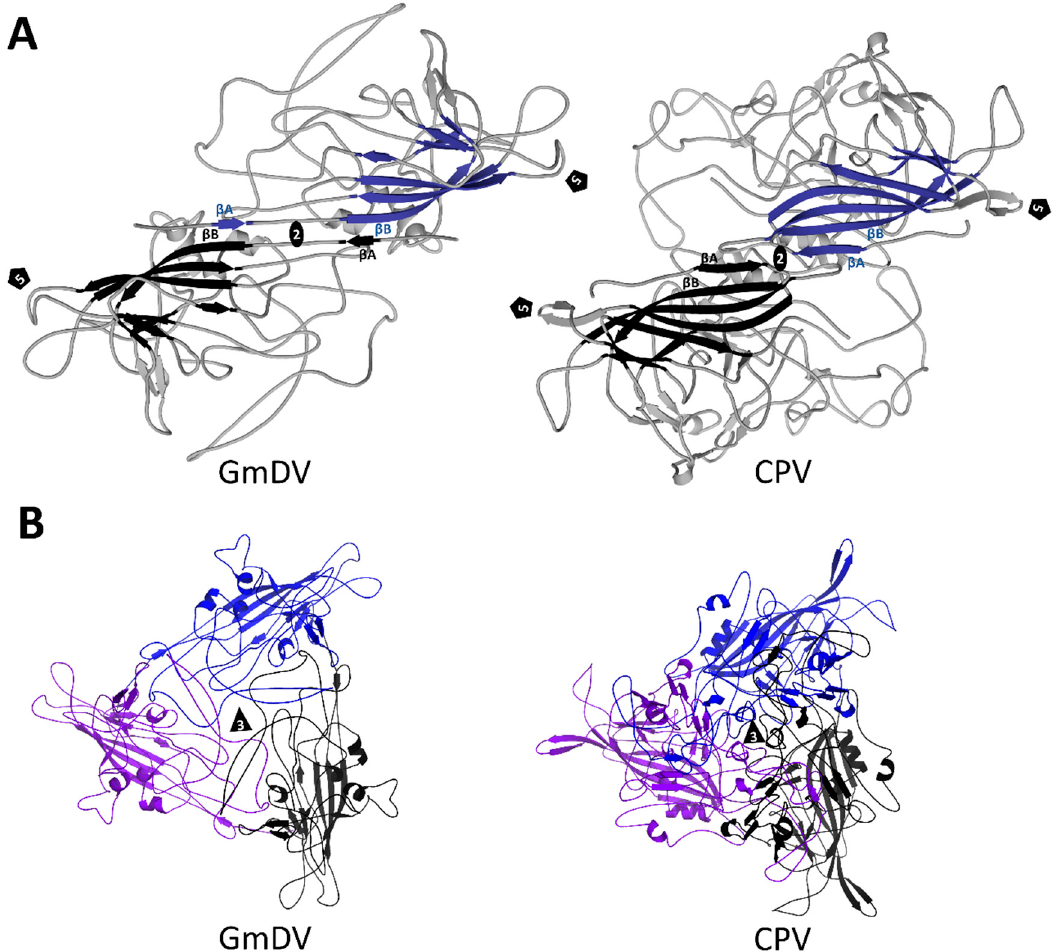
Figure 13. Multimeric interactions of densoviral and parvoviral VPs. ( A ) Ribbon cartoon diagrams of the interactions between β A and β B at the 2-fold symmetry axis of GmDV and CPV. The eight-stranded core, with the additional β A, which performs the domain swapping, are colored blue and black. ( B ) Interaction of three 3-fold symmetry related VPs for GmDV and CPV. The open annulus-like structure at the 3-fold axis of the densovirus trimer compared to the more closed arrangement in the vertebrate parvoviruses is evident. The triangle indicates the 3-fold axis and the pentagon the 5-fold axis.